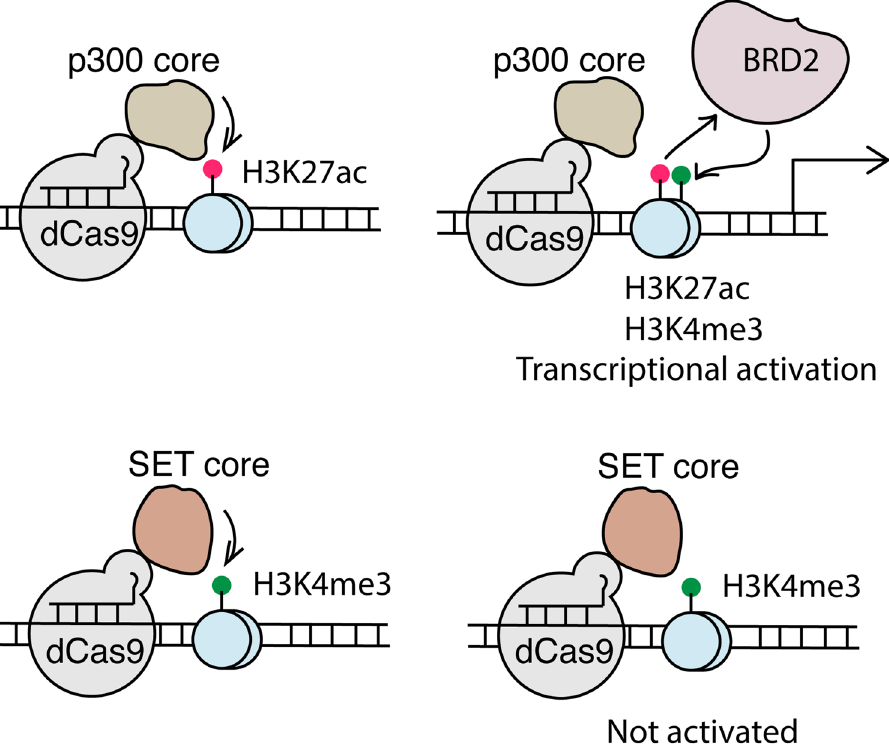
Figure 1. Investigating the H3K27ac/H3K4me3 crosstalk and functions through CRISPR/dCas9 based epigenome editing